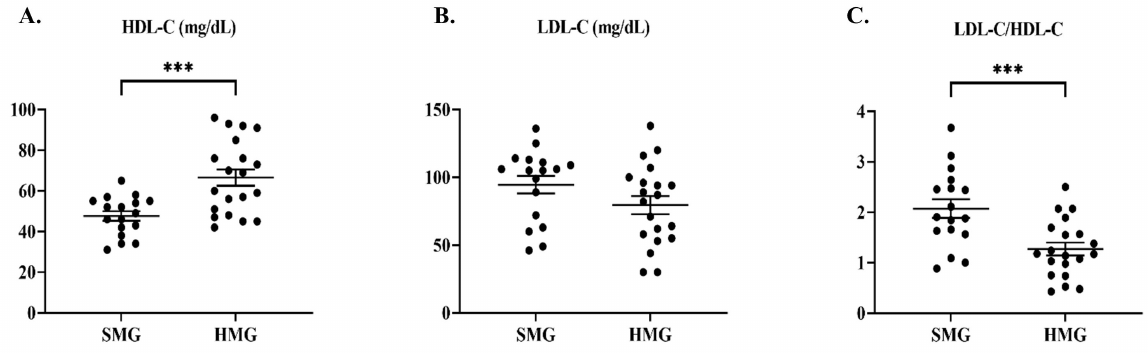
Fig. 2. Comparison of blood parameters between SMG and HMG. Comparison of HDL-C (A), LDL-C (B), and LDL-C/HDL-C (C) between groups. SMG, standard skeletal muscle mass group; HMG, high skeletal muscle mass group; HDL-C, high density lipoprotein cholesterol; LDL-C, low density lipoprotein cholesterol; LDL-C/HDL-C, LDL-C to HDL-C ratio. *** p < 0.001 compared between groups.